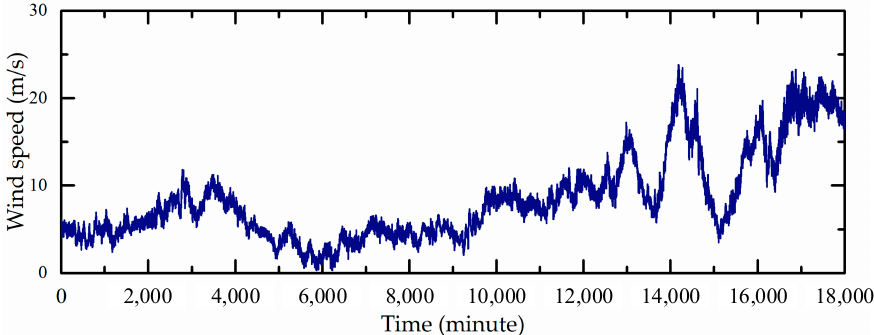
Figure 13. The wind speed series with the sample time of one second.